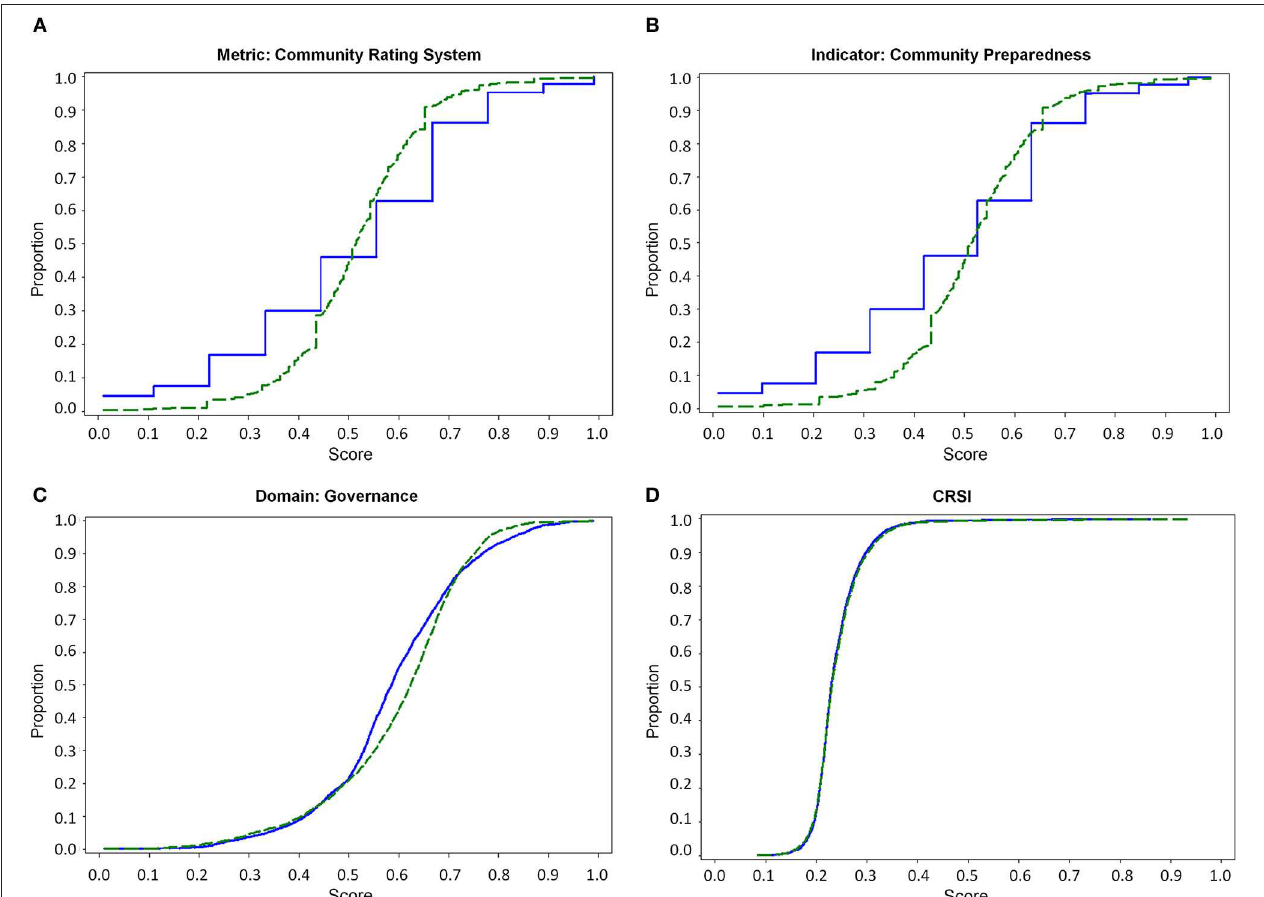
FIGURE 5 | Cumulative distribution function (CDF) analyses were performed for each suite of metrics, indicators, domains and CRSI values. Graphs were used to identify possible processing errors and to understand how errors influence the different aggregates of results: (A) the stair-step pattern of the “Before Correction” CDF suggests that a problem existed in the suite of Community Rating System metrics while the “After Correction” CDF shows the more expected distribution pattern; (B) demonstrates the level of influence a single metric can exert on an indicator; (C) illustrates the difficulty in identifying the metric error at the domain-level of CRSI calculations; and (D) shows that the metric-level error is virtually undetectable in the final index (CRSI) values.